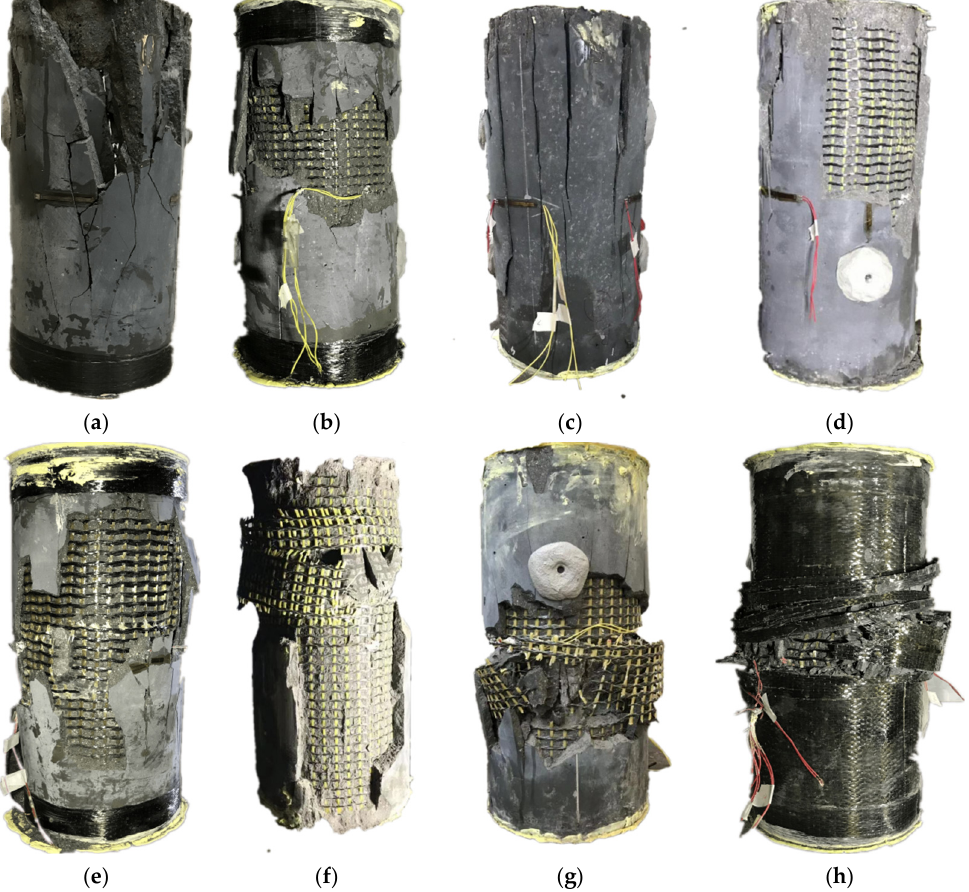
Figure 9. Typical failure modes of test columns. ( a ) H-L0-0-II; ( b ) H-A2-0-II; ( c ) H-B2-0-II; ( d ) H-A1C1-0-I; ( e ) S-A2-0-II; ( f ) S-B2-0-I; ( g ) S-A1C1-0-I; ( h )